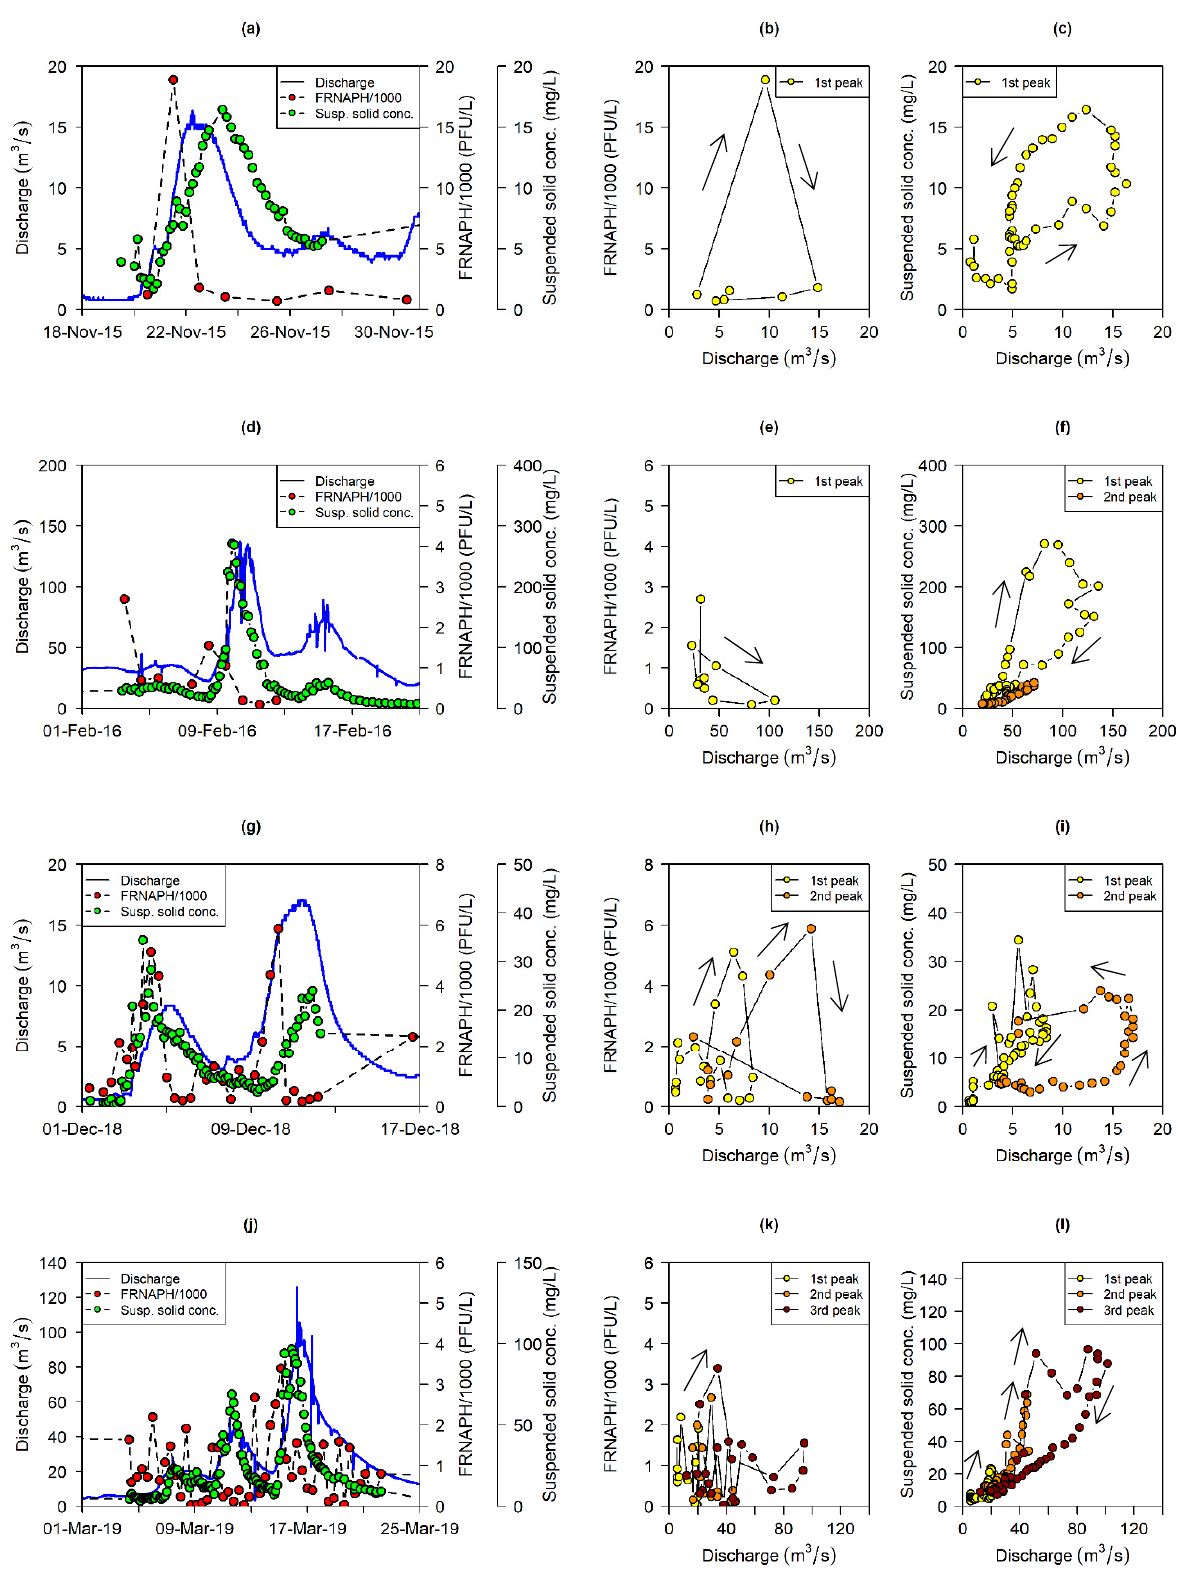
Figure 4. River discharge (Q), F-specific RNA bacteriophage concentrations (FRNAPH) and suspended solid concentration measured during the four runoff events in ( a ) November 2015, ( d ) February 2016, ( g ) December 2018 and ( j ) March 2019. For each runoff event, relationship between river discharge and FRNAPHs concentrations ( b , e , h , k ), and between discharge and suspended solid concentrations ( c , f , i , l ).